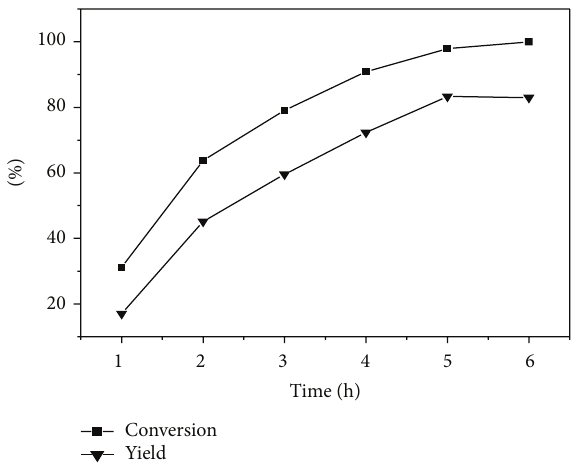
Figure 5: Effect of reaction time on the glycolysis of PET.